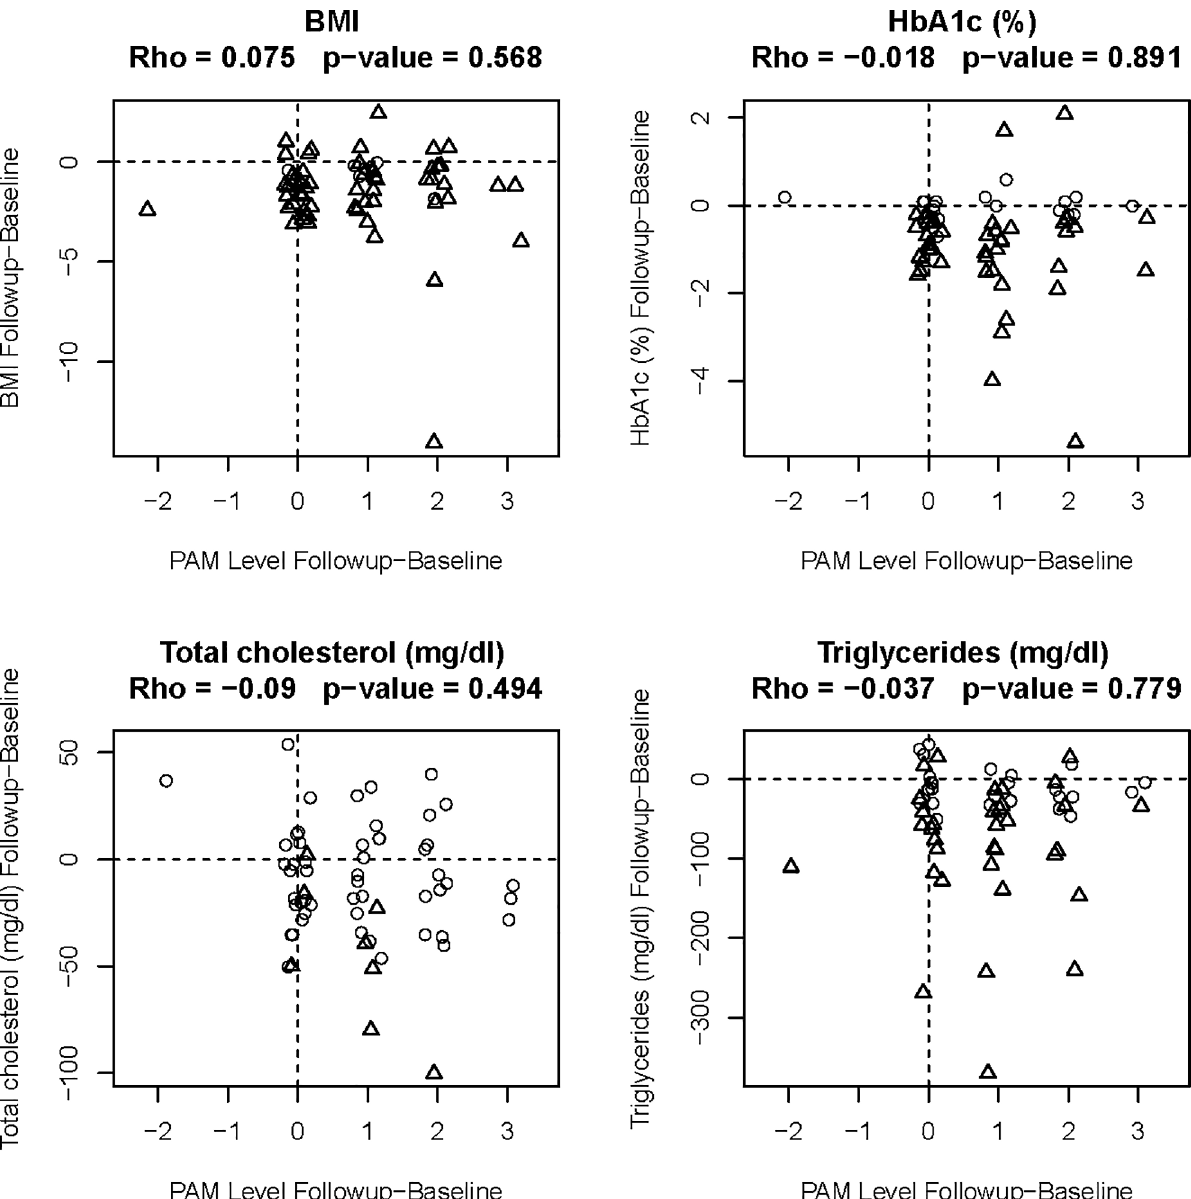
Fig 3. Regression analysis showing changes in clinical parameters vs. changes in PAM levels (n = 60). For each clinical parameter the change in PAM level from baseline to 6 months is depicted on the horizontal axis and change in the clinical parameter from baseline to 6 months is depicted on the vertical axis. Reported values are Spearman ’ s rho (nonparametric correlation coefficient), and the corresponding p-value (calculated on original, not jittered values). A more sophisticated regression analysis adjusting for age, gender and baseline values had similar p-values and is not shown.